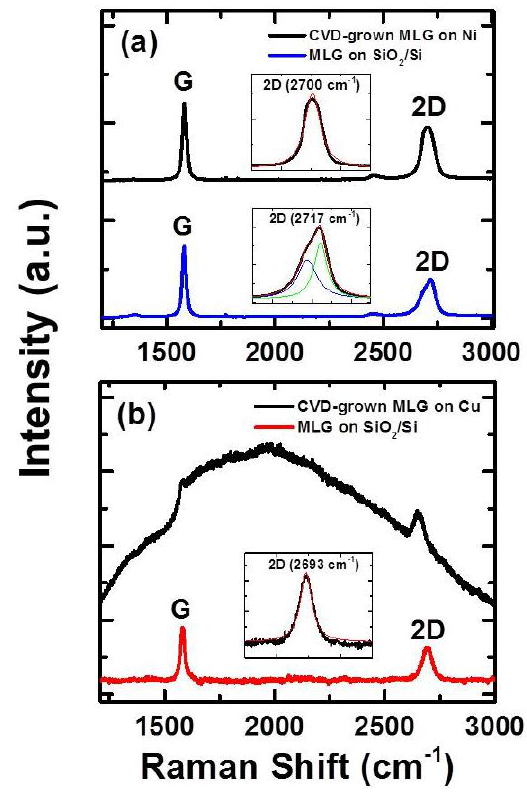
Figure 2. Raman spectroscopy of epitaxially-grown MLG. ( a ) CVD-grown MLG on polycrystalline nickel; and ( b ) CVD-grown MLG on copper. Data from before and after transferring the MLG on SiO /Si are presented. The excitation wavelength is 532 nm. 2 In ( a ), the 2D peak is symmetric before the transfer and can be fitted with a single Lorentzian (top inset). The 2D peak becomes asymmetric (bottom inset, Figure 2( a )) after the transfer, which is due to the high temperature etching process. In ( b ), the 2D peak is symmetric, even after the transfer, and can be fitted with a single Lorentzian (inset). A background signal from the Cu substrate is present before the